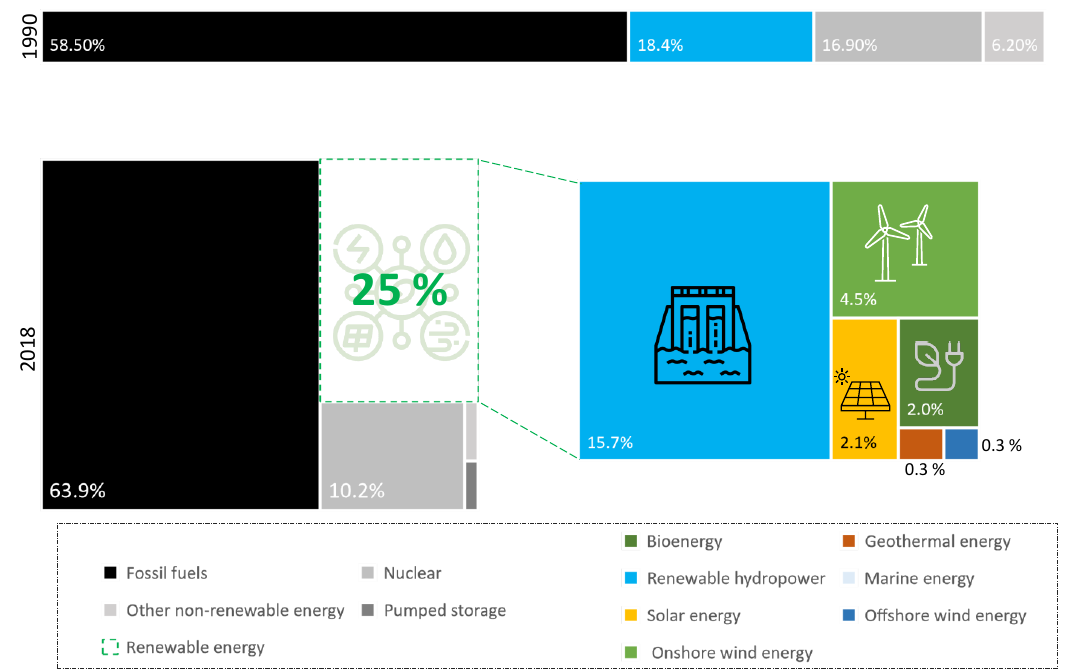
Figure 1. Electricity generation evolution in the world (source: own